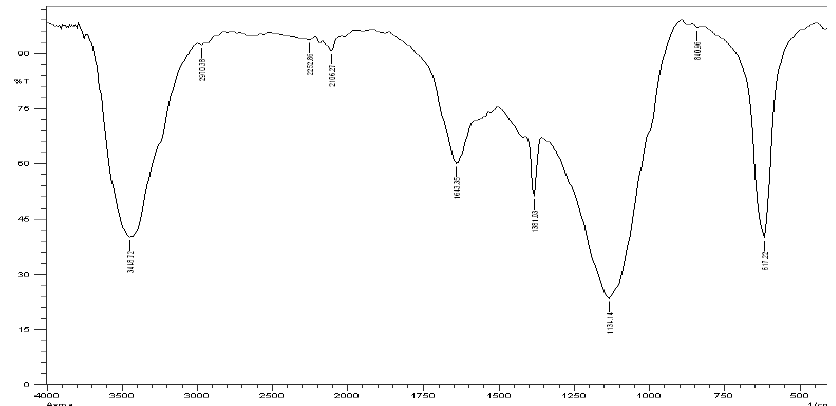
Fig. 7. FTIR spectra of the EPS produced by Halomonas sp. NASH